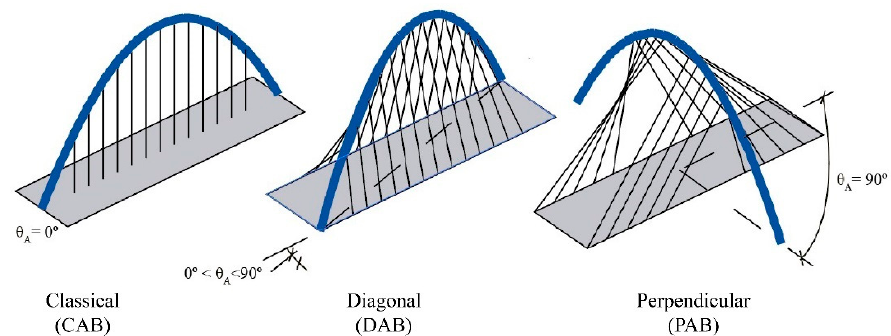
Figure 16. Bridge typology attending to θ A .